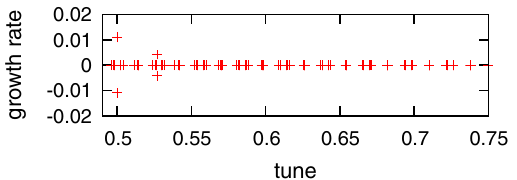
FIG. 20. Eigenvalues and growth rate as a function of the tune ðþÞ ¼ 0 . 53 and ν ð − Þ ¼ 0 . 57 at SuperKEKB. for ν x x